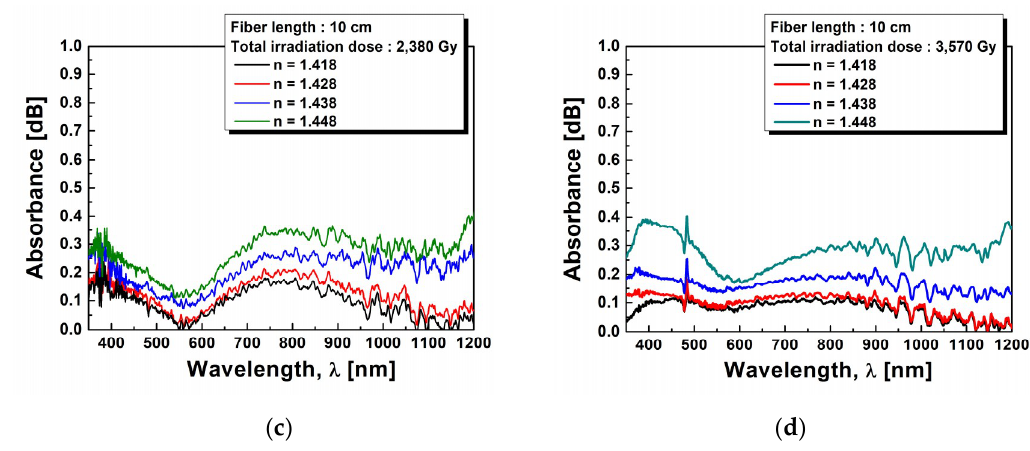
Figure 5. The SPR spectra obtained by dropping the matching oils of different refractive indices (a) before and after the γ‐ray irradiation at the total dose of (b)1190 Gy, (c) 2380 Gy, and (d) 3570 Gy.